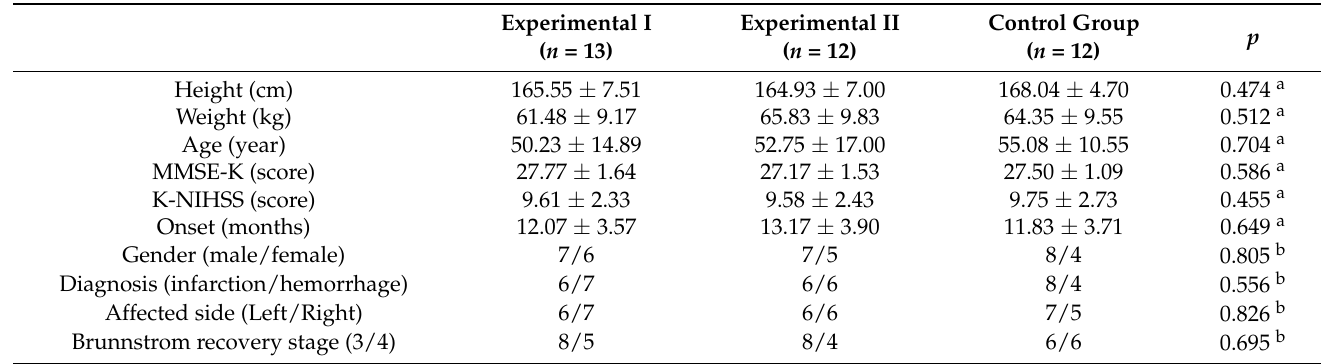
Table 2. General characteristics of participants.